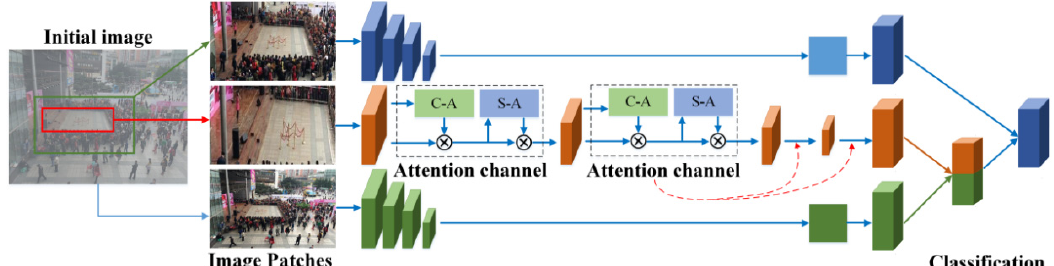
Figure 5. Proposed MAN.